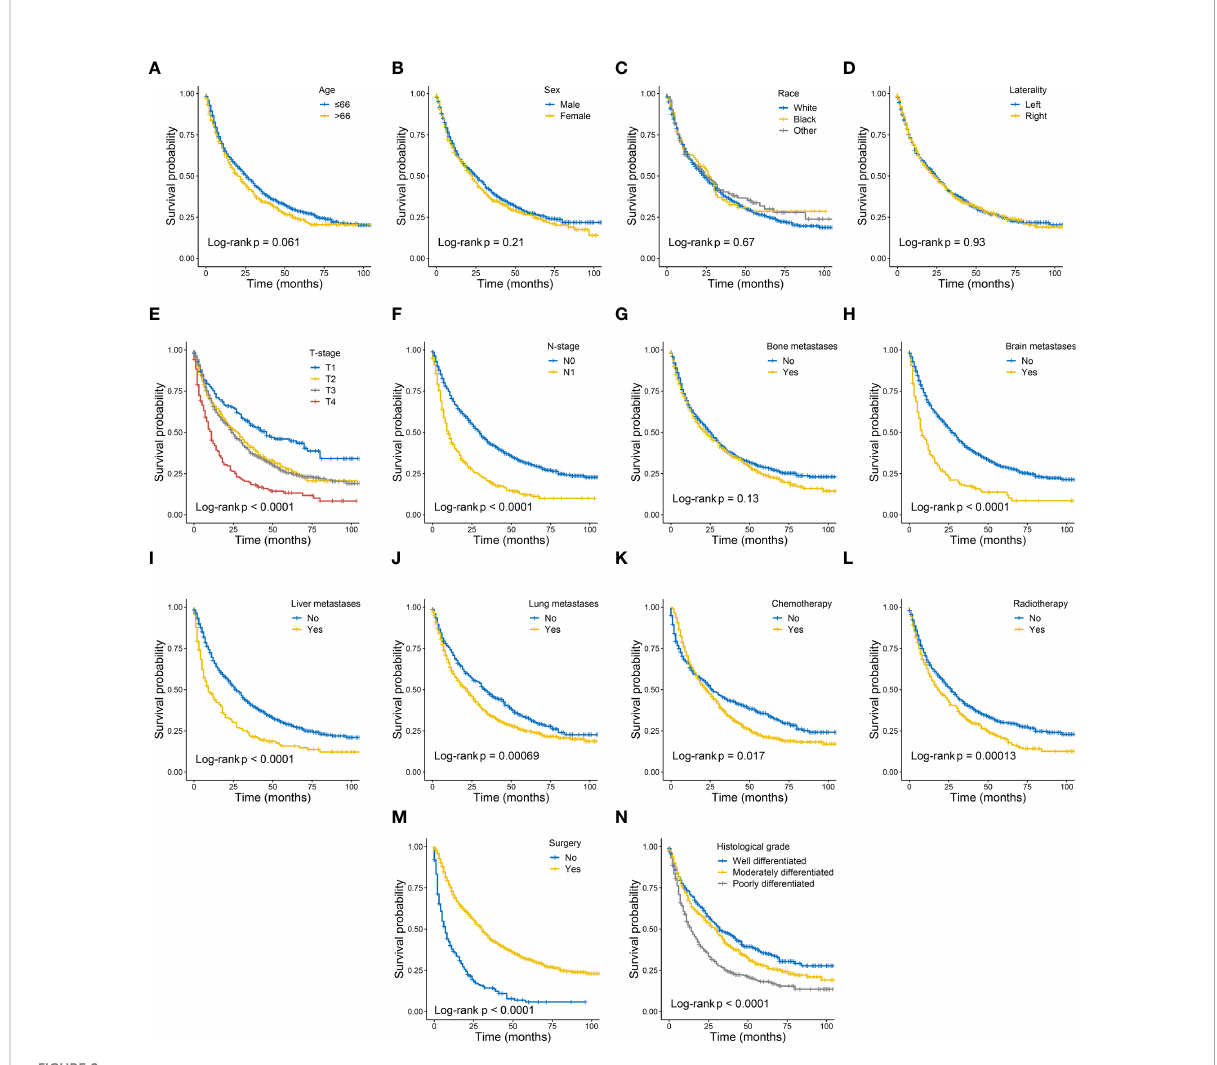
FIGURE 2 Kaplan – Meier curves of cancer speci fi c survival in patients with metastatic clear cell renal cell carcinoma strati fi ed by age (A) , sex (B) , race (C) , laterality (D) , T-stage (E) , N-stage (F) , bone metastases (G) , brain metastases (H) , liver metastases (I) , lung metastases (J) , chemotherapy (K) , radiotherapy (L) , surgery (M) and histological grade (N)